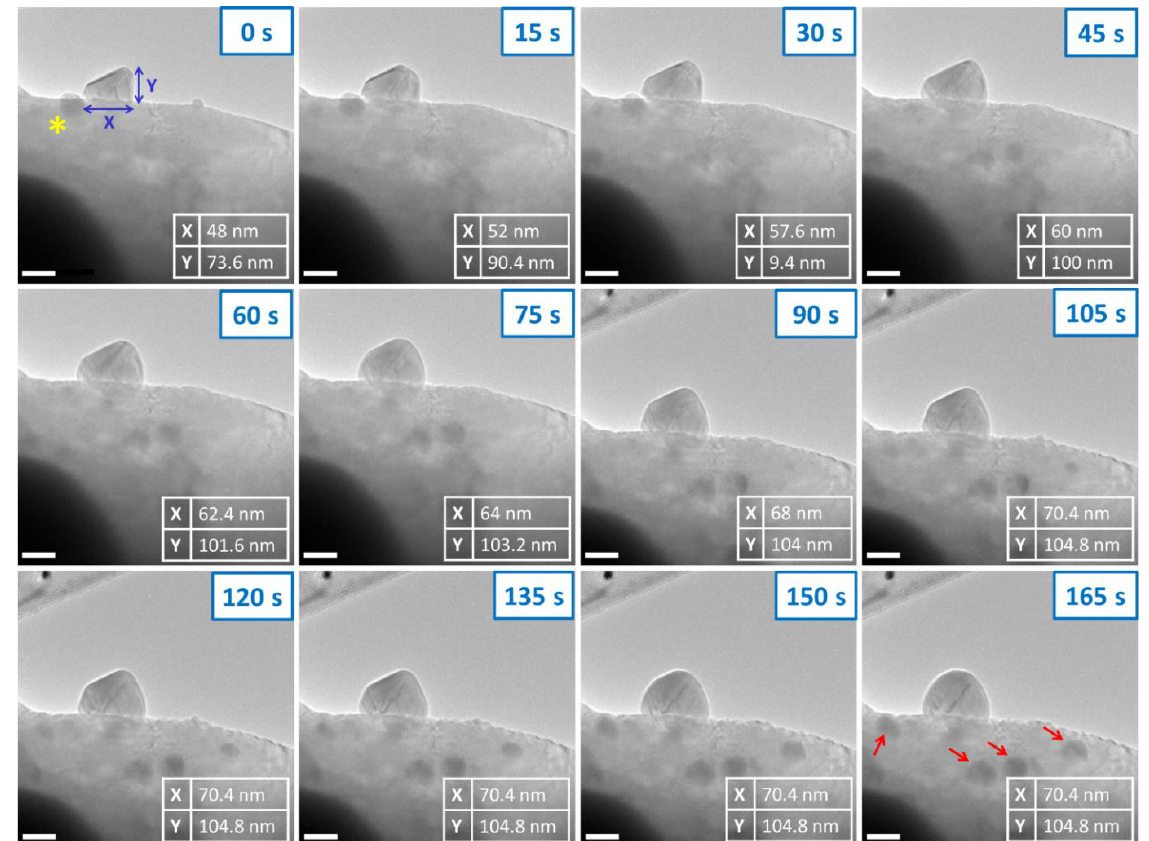
Figure 3. TEM image series of the electron beam irradiation effect on the Cu 2 O sample exfoliated with isopropanol, with growing structure dimensions measurements. Arrows indicate the appearance of new particles; the asterisk indicates particle absorbed into a larger structure. Scale bars: 50 nm.